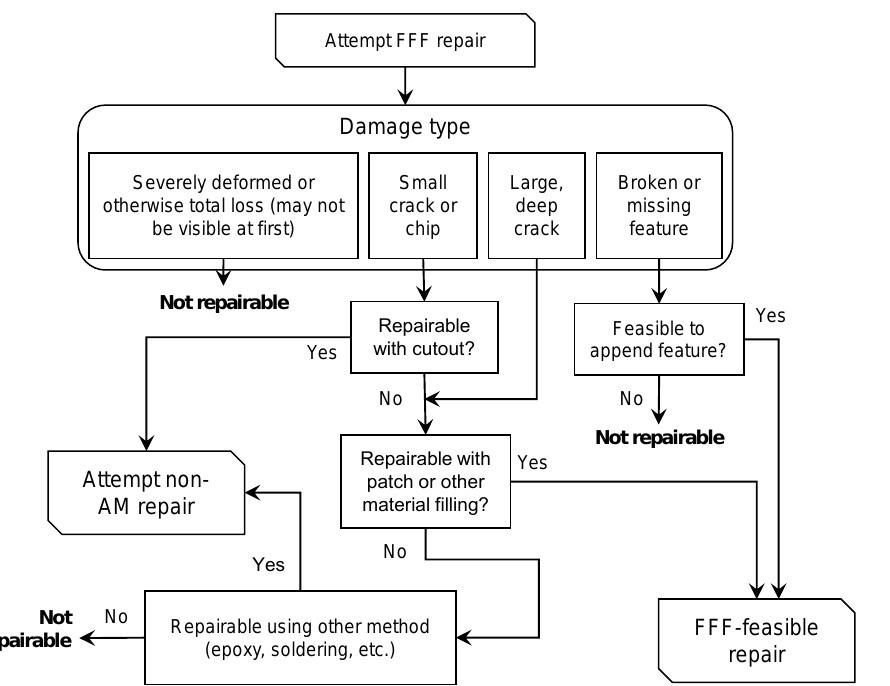
Figure 6. Decision-making process for FFF repair after screening